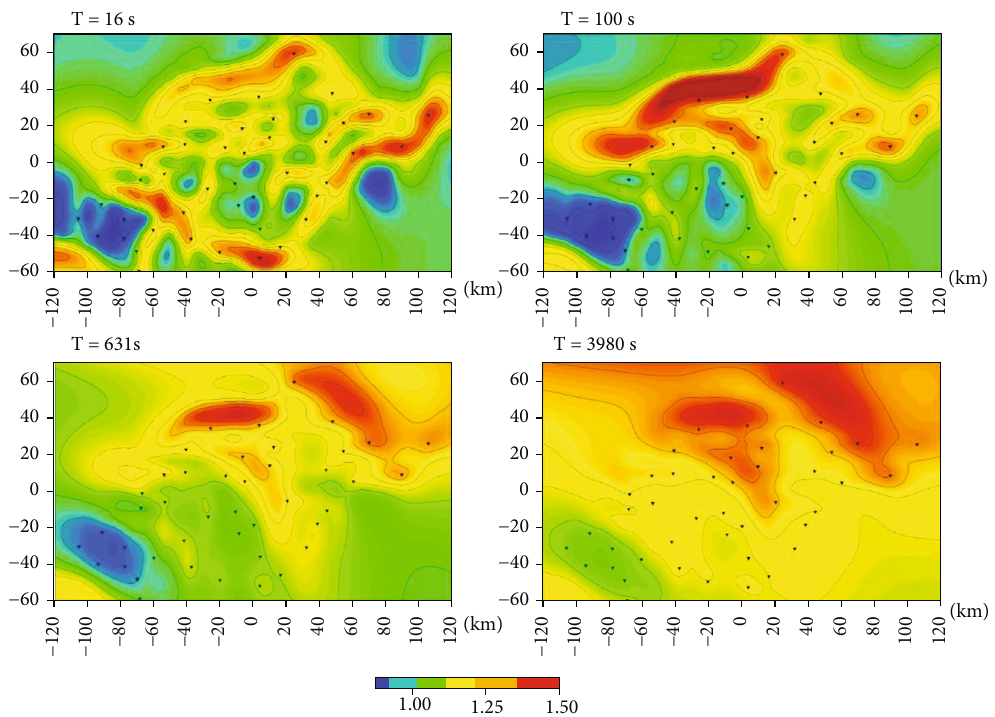
Figure 6: Presentation of horizontal magnetic tensor for selected periods (16, 100, 631, and 3980